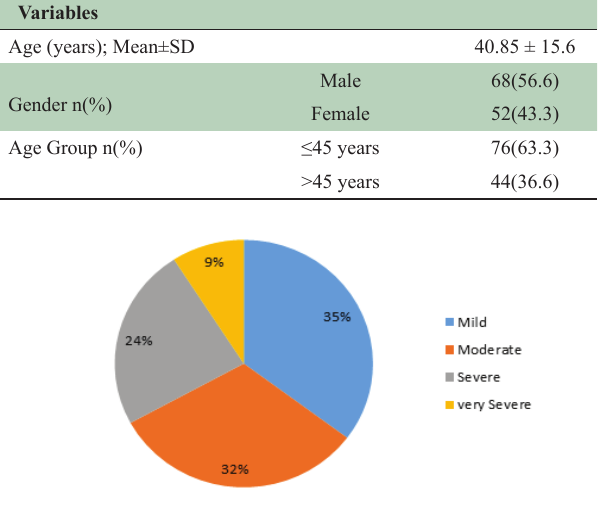
Figure-I: Degree of thrombocytopenia in the study population.